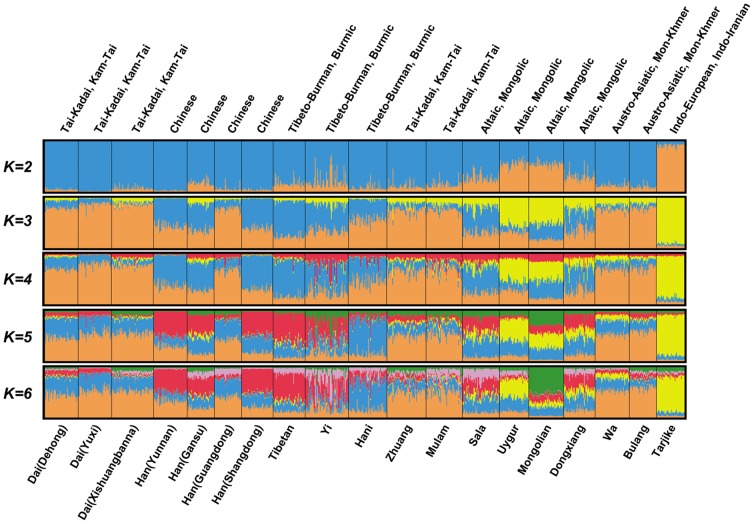
Clustering analysis from STRUCTURE.Population structure was investigated using STRUCTURE software assuming K = 2, 3, 4, 5, 6. Populations were ordered according to their linguistic affiliations. Linguistic affiliations and population names are labeled above and beneath the plot. According to the guidelines in the STRUCTURE manual, K = 5 is the most appropriate value.